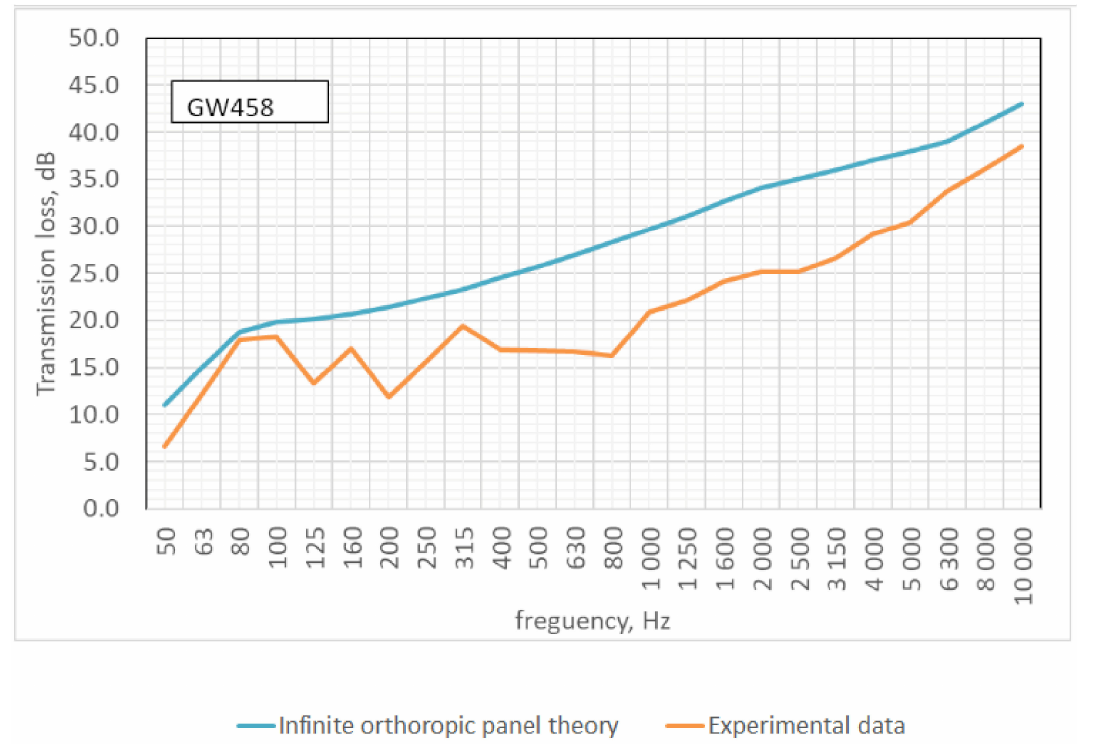
Figure 8. Measured (experimental) and predicted (theory) transmission loss (TL) for GW610 and GW458 PVC panels. Table 3. Measured and predicted transmission loss for GW270 and GW300 PVC